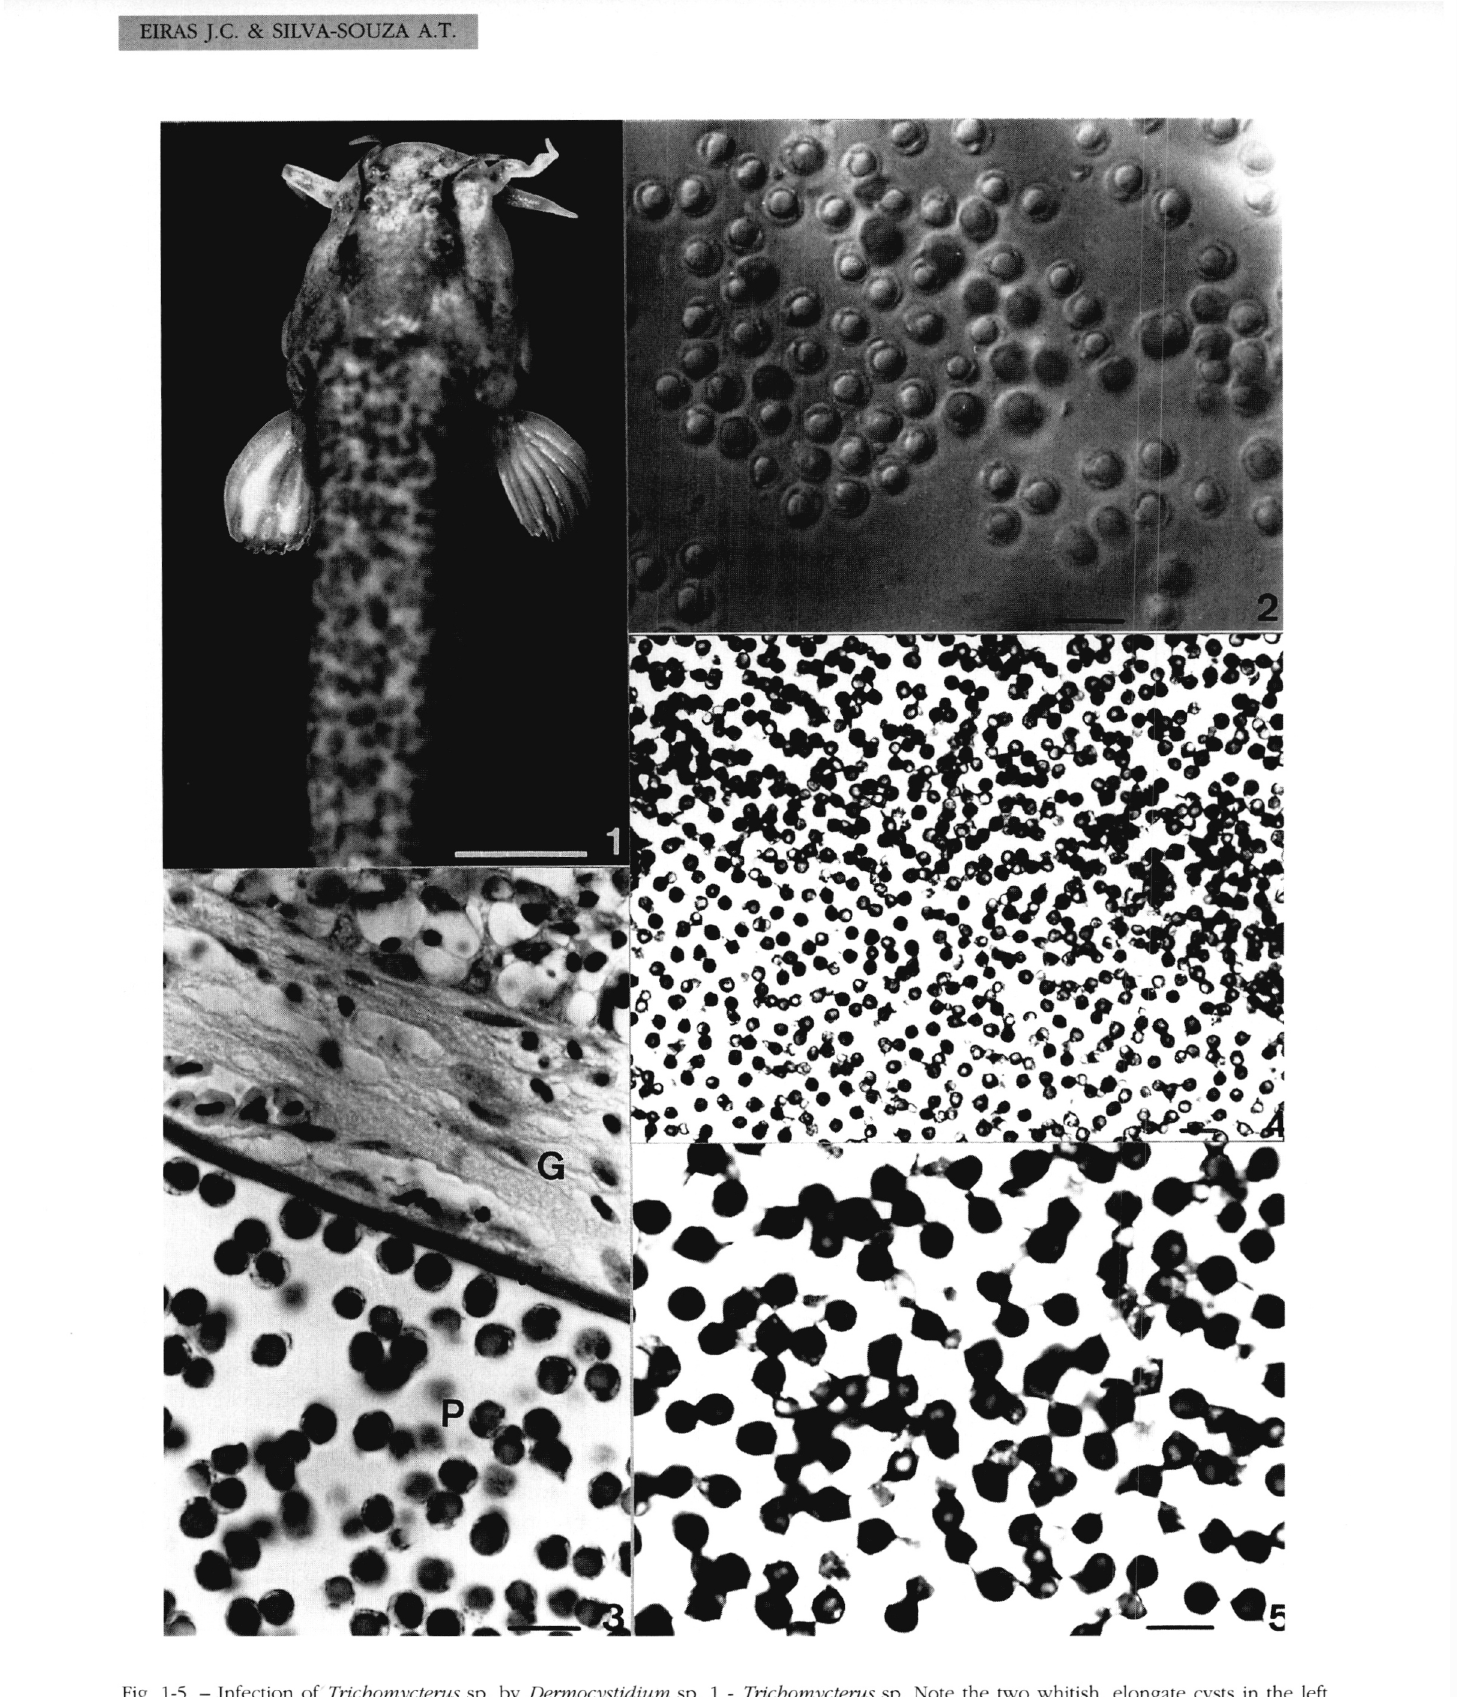
Parasite, 2000, 7,